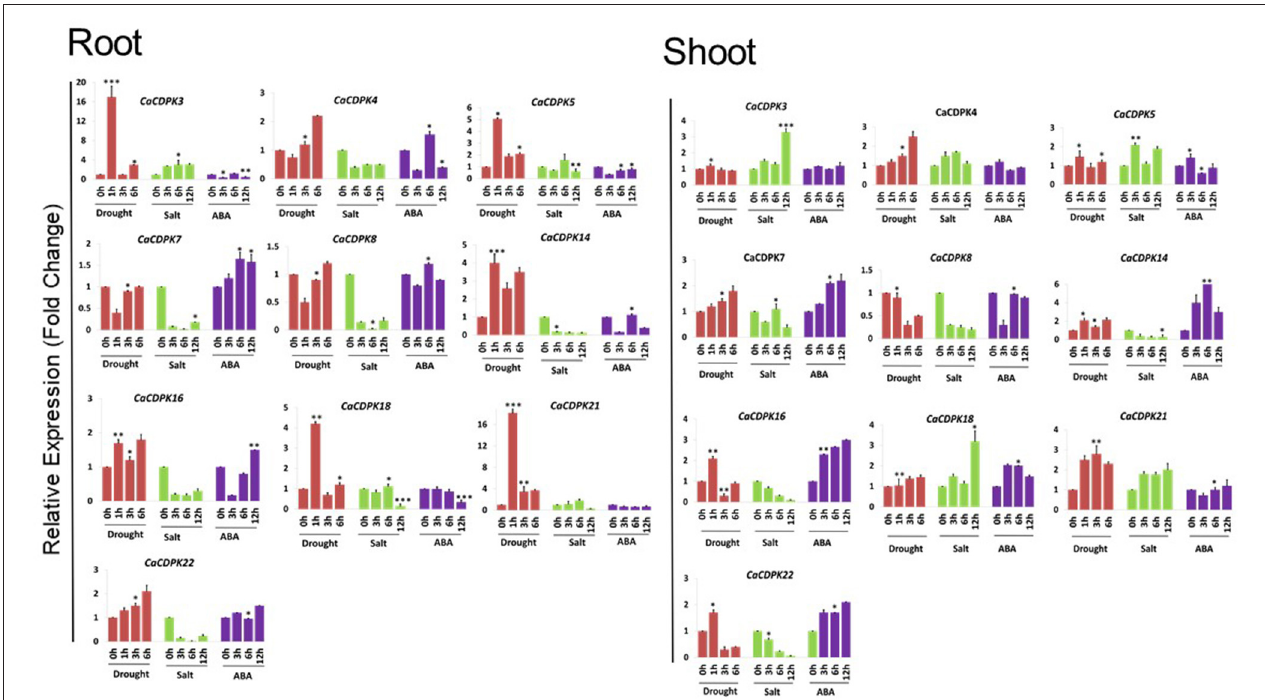
FIGURE 9 | Expression profiles of CDPK genes under drought, salt, and ABA treatments in chickpea. qRT-PCR analysis was performed to generate the expression profile of CaCDPK genes under drought, salt, and ABA treatment in root and shoot of desi chickpea (ICC4958). Different treatments and time points are indicated on X-axis and the relative expression level of the gene is indicated on Y-axis. Each bar represents the mean value of three replicates. Standard error among the samples is indicated by error bars. * p < 0.05, ** p < 0.01 and *** p < 0.005 for treated samples w.r.t. untreated